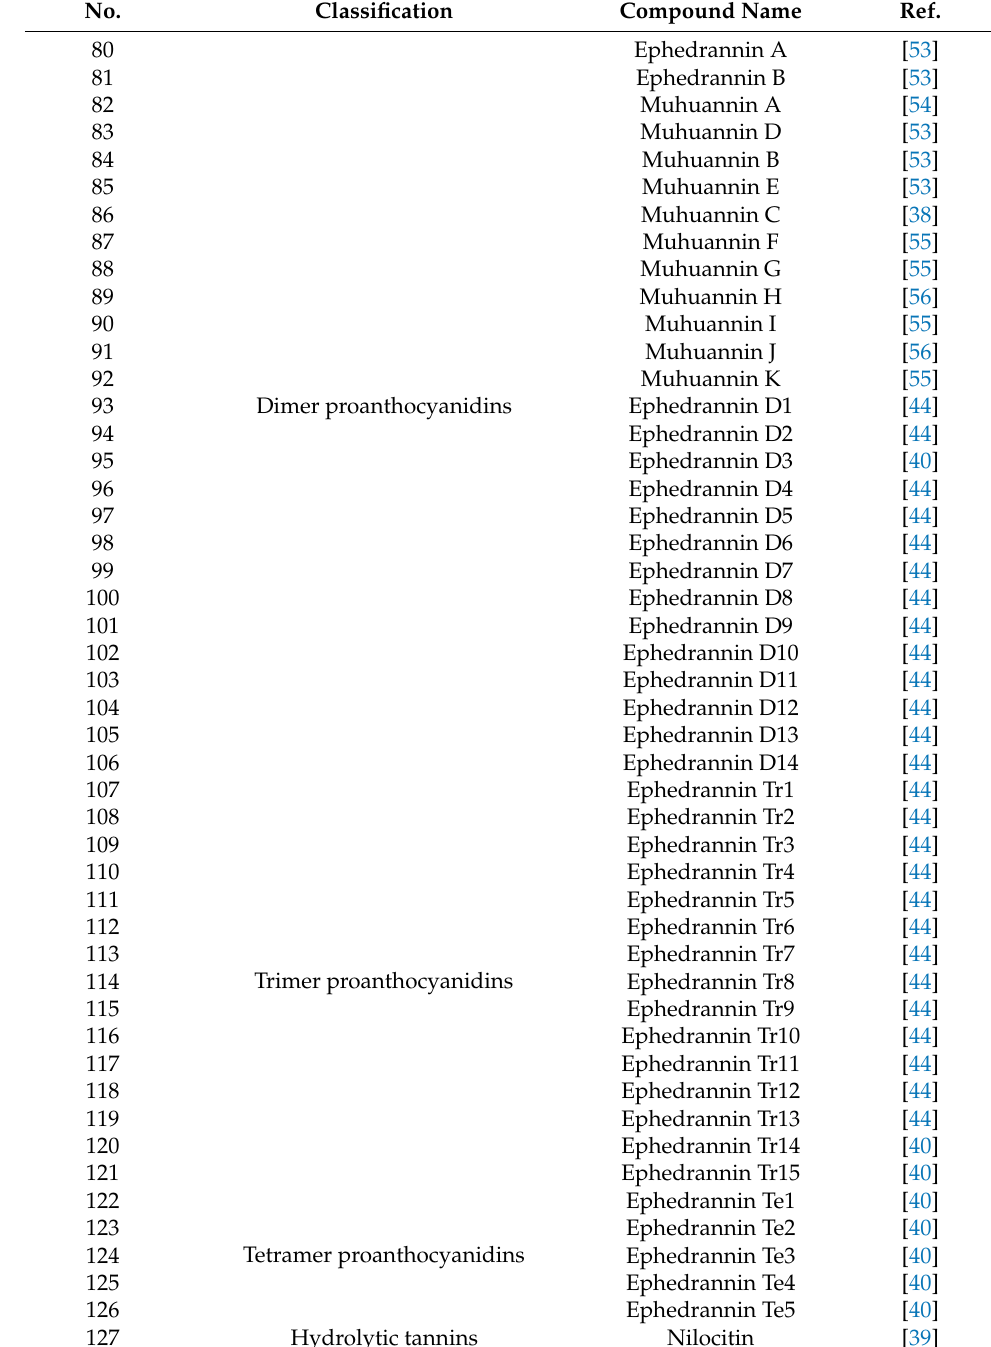
Table 3. Tannins in Ephedra sinica Stapf (structural formulas are shown in Figure S3). No.